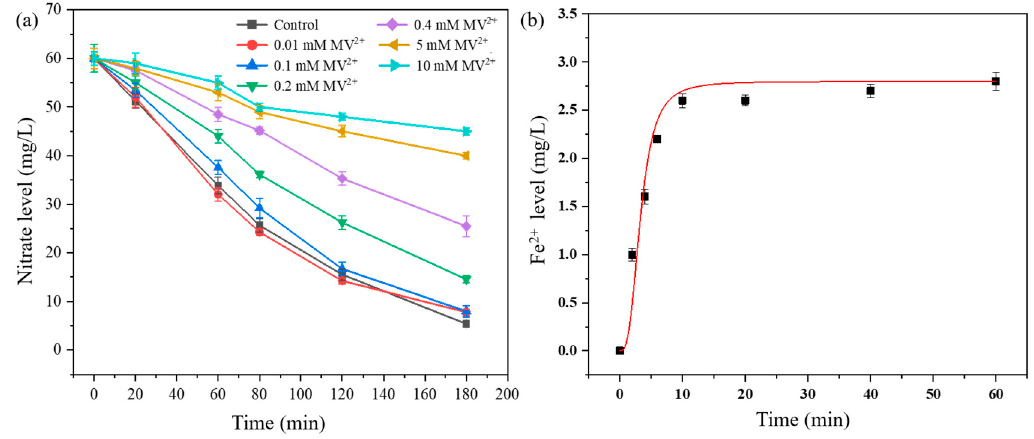
Figure 5. ( a ) The effect of MV 2+ concentrations on NO 3 ‒ reduction and ( b ) time profiles of ferrous iron level in the UV/C 2 O 42 ‒ /Fe 3+ systems. Experimental conditions: [NO 3 ‒ ] 0 = 60 mg/L, [C 2 O 42 ‒ ] 0 = 3 mM, [Fe 3+ ] 0 = 0.05 mM, I 0 = 10.2 mW/cm 2 (wavelength = 365 nm), [DO] 0 = 0.5 ± 0.1 mg/L, pH ini. = 7.0 ± 0.2, and T = 25 ± 0.5 °C. Error bars represent the standard deviation from three experiments.